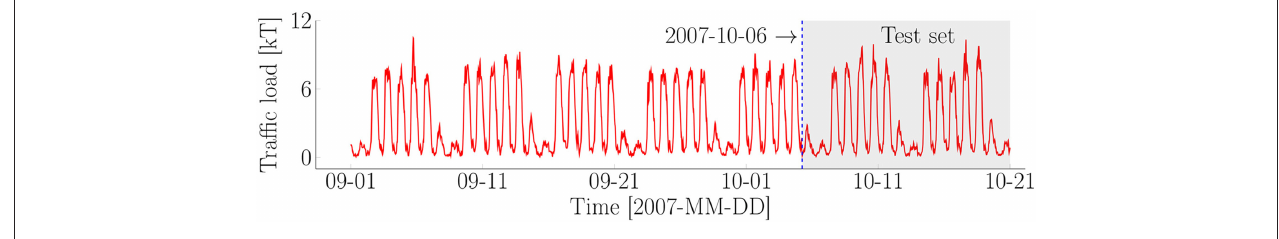
FIGURE 6 | Traffic load on the Tamar Bridge in the United